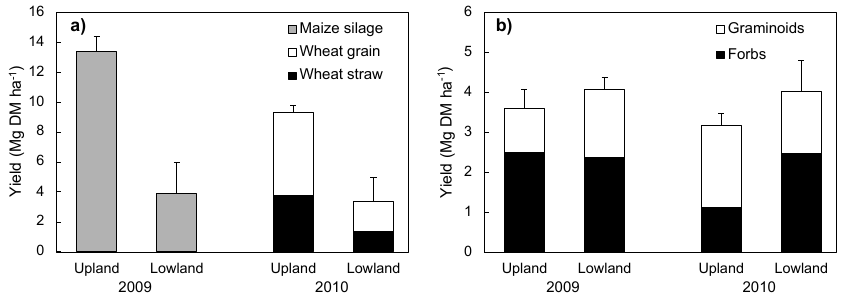
Figure 1. Upland and lowland yields in ( a ) row crops; ( b ) prairie. Error bars show the standard error of total yield. Note the differences in scale between panels. Table 1. Soil properties in upland and lowland row crops and prairies (mean with standard error).